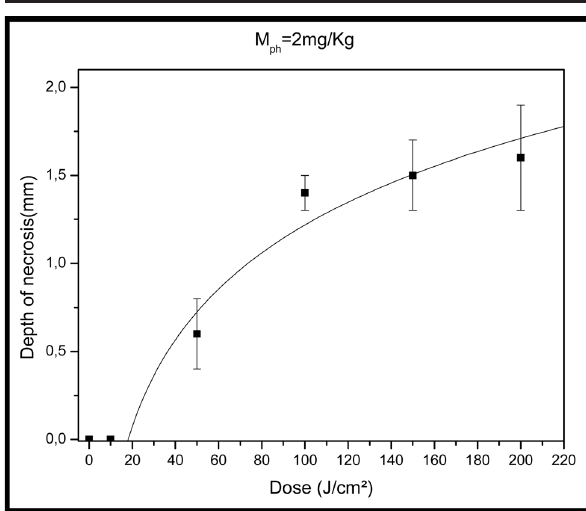
FIGURE 2 - Depth of necrosis as a function of light